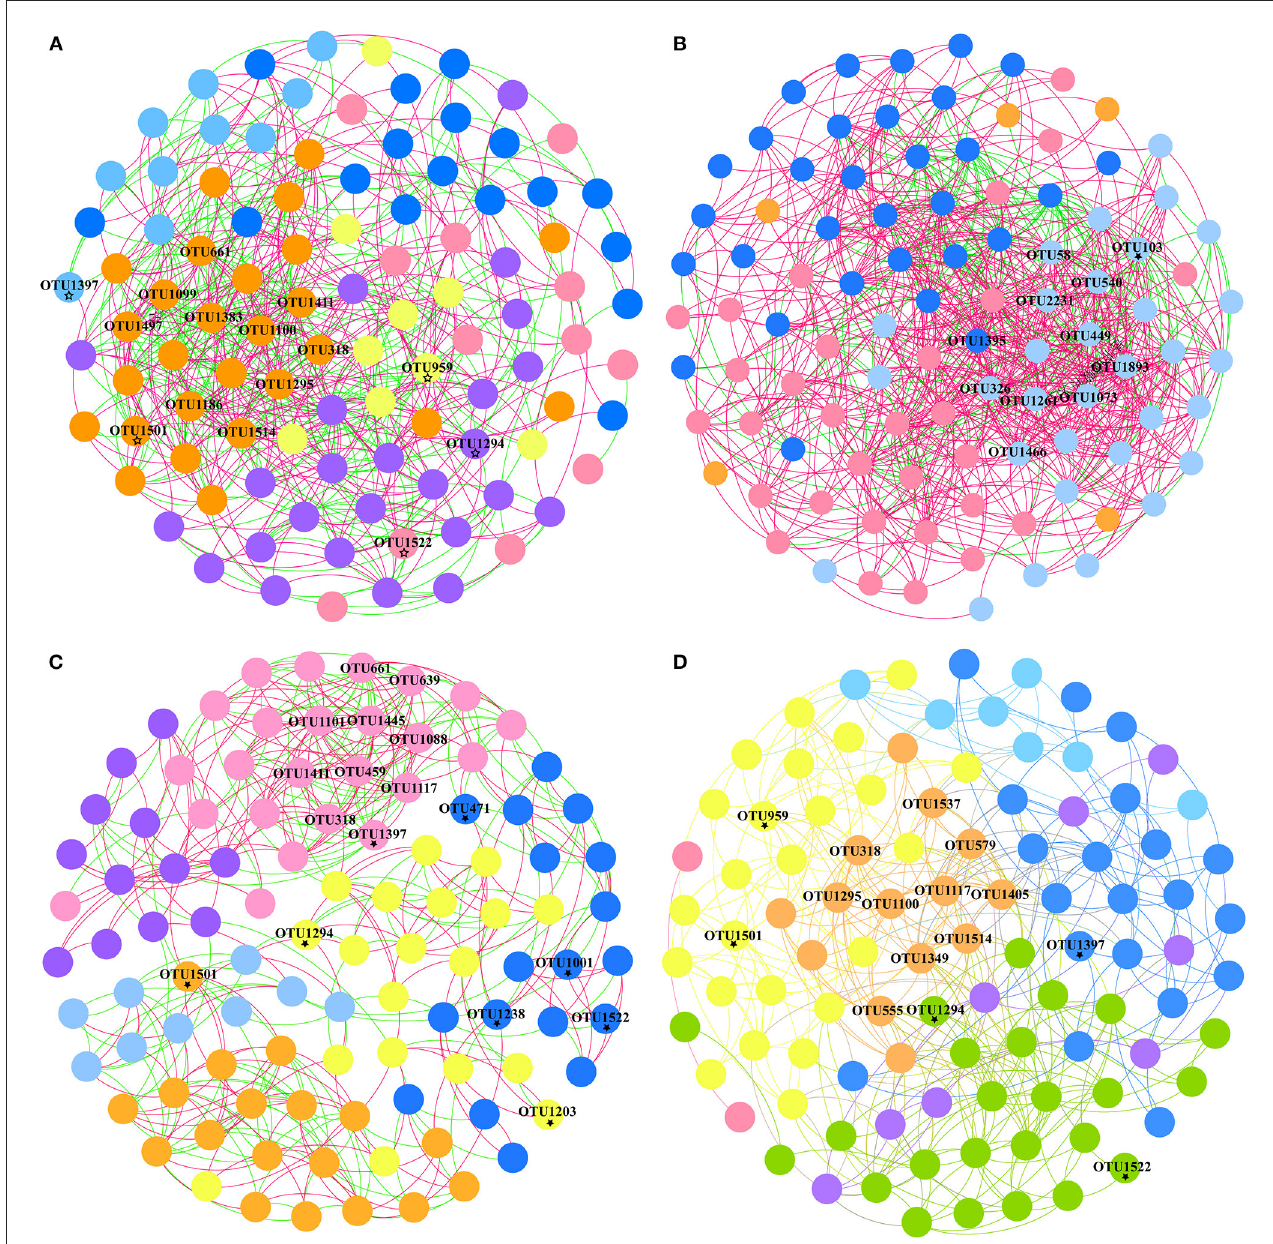
FIGURE5 Network modules and connectivity of OTUs in different groups. Co-occurrence networks of OTUs present different modules in captive (A) , wild (B) , captive female (C) , and captive male groups (D) with positive and negative correlations (top 30 OTUs derived from random forest results indicated by ⋆ ).